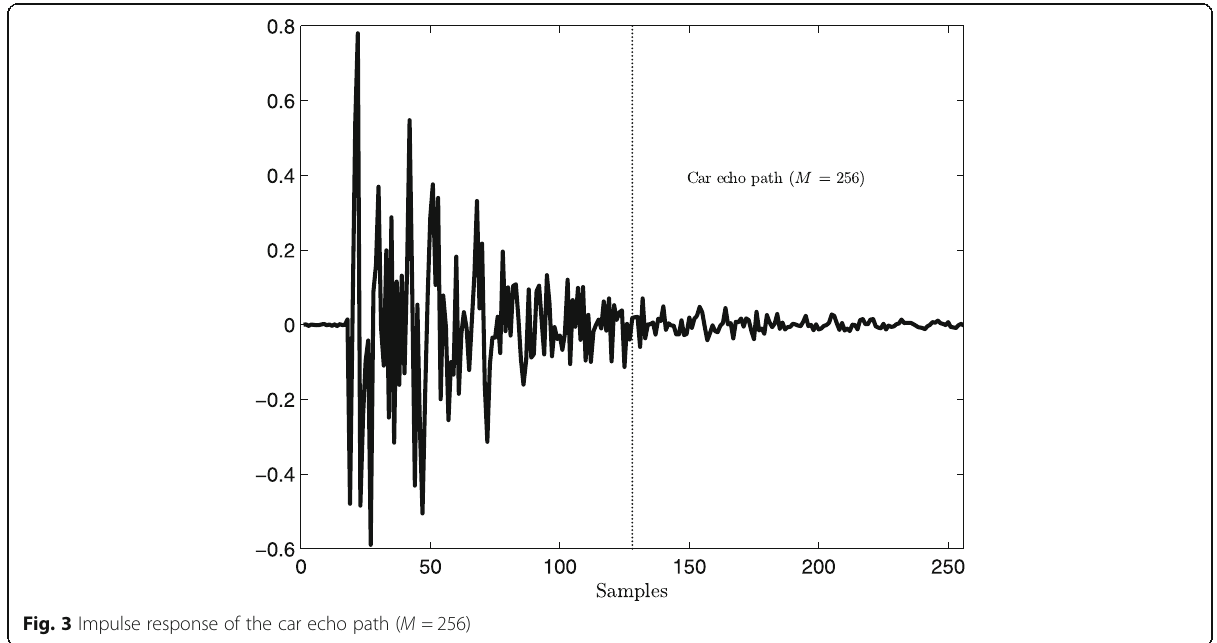
Fig. 3 Impulse response of the car echo path ( M =